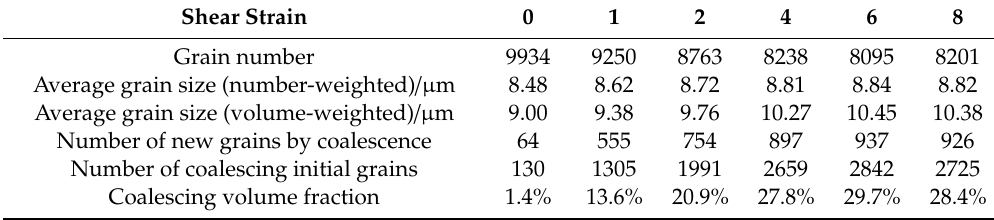
Table 1. Grain coalescence analysis results for the polycrystal with random initial texture.